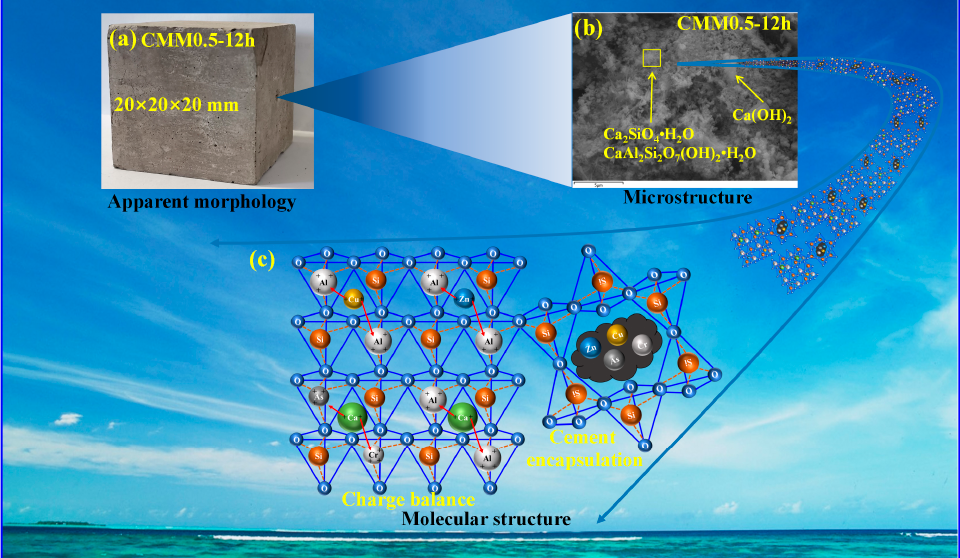
Figure 18. The consolidation mechanism of heavy metals of the CMM0.5–12 h ( a : Apparent; b : Microstructure; c : Molecular).